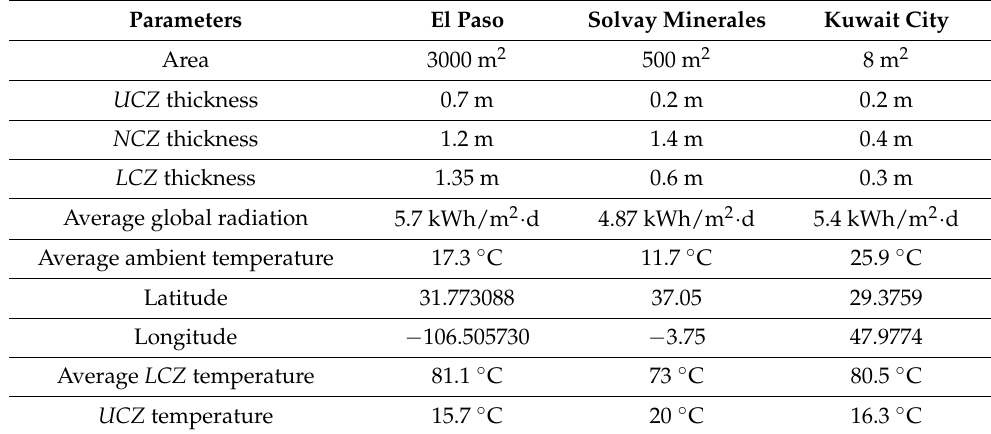
Table 1. Specification of El Paso, Solvay Minerales and Kuwait City solar ponds.